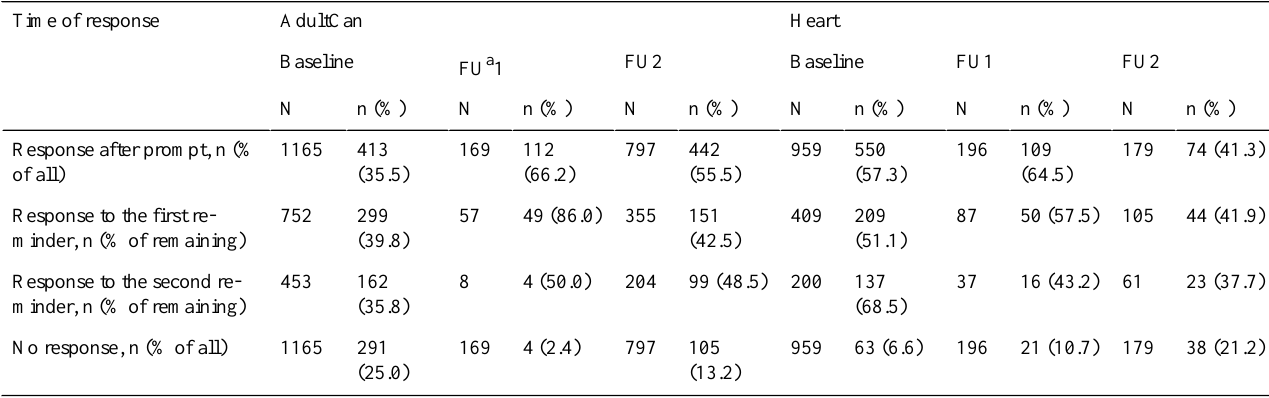
Table 7. Responses to reminders at baseline and the 2 follow-ups. HeartAdultCanTime of